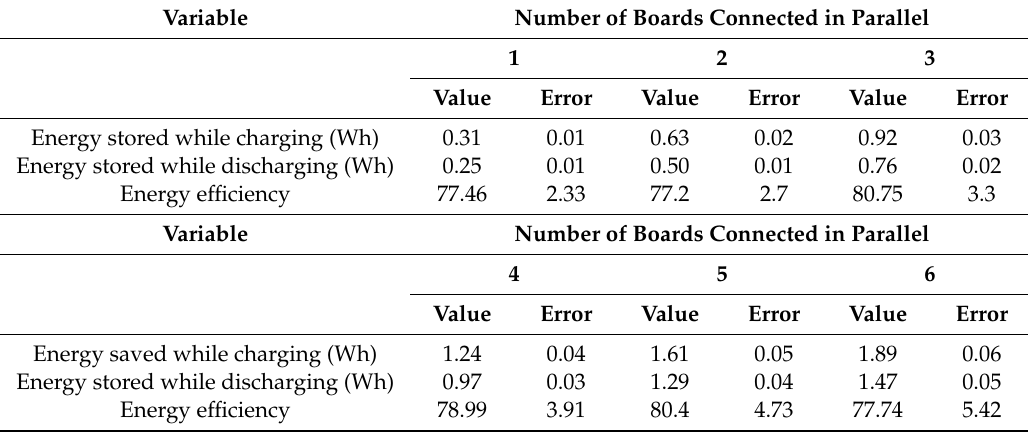
Table 12. Results for energy calculation in the ultracapacitors.